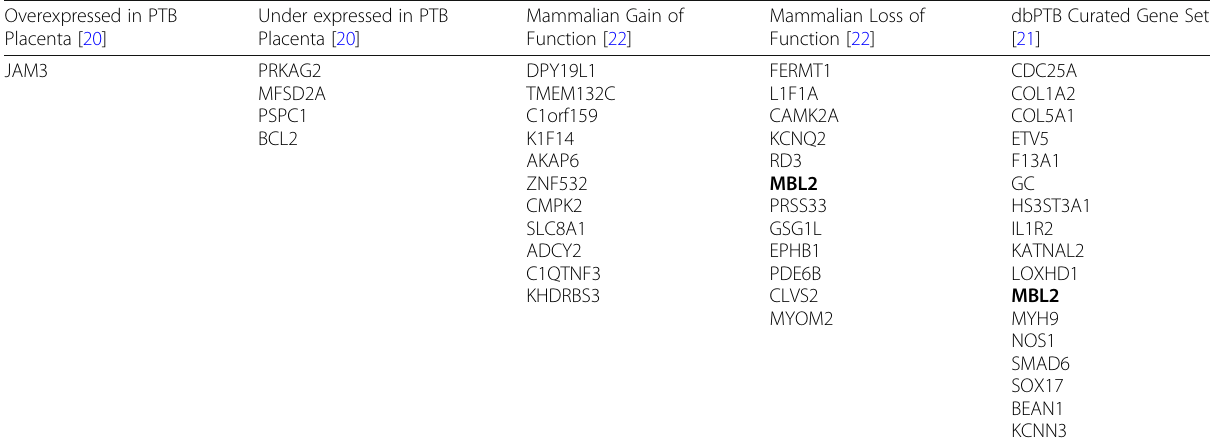
Table 5 Comparative Analysis of Nearest Genes to DMRs associated with Gestational Age Overexpressed in PTB Placenta